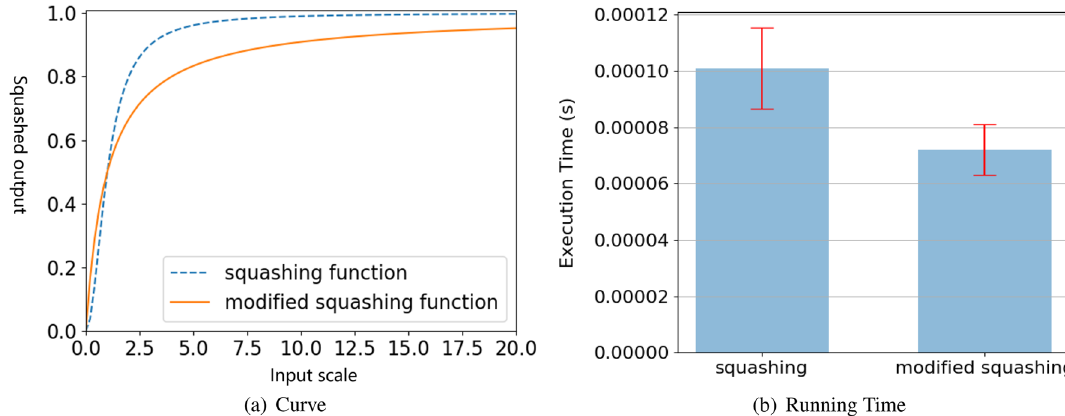
Figure 2. Different types of non-linear mapping function curve.